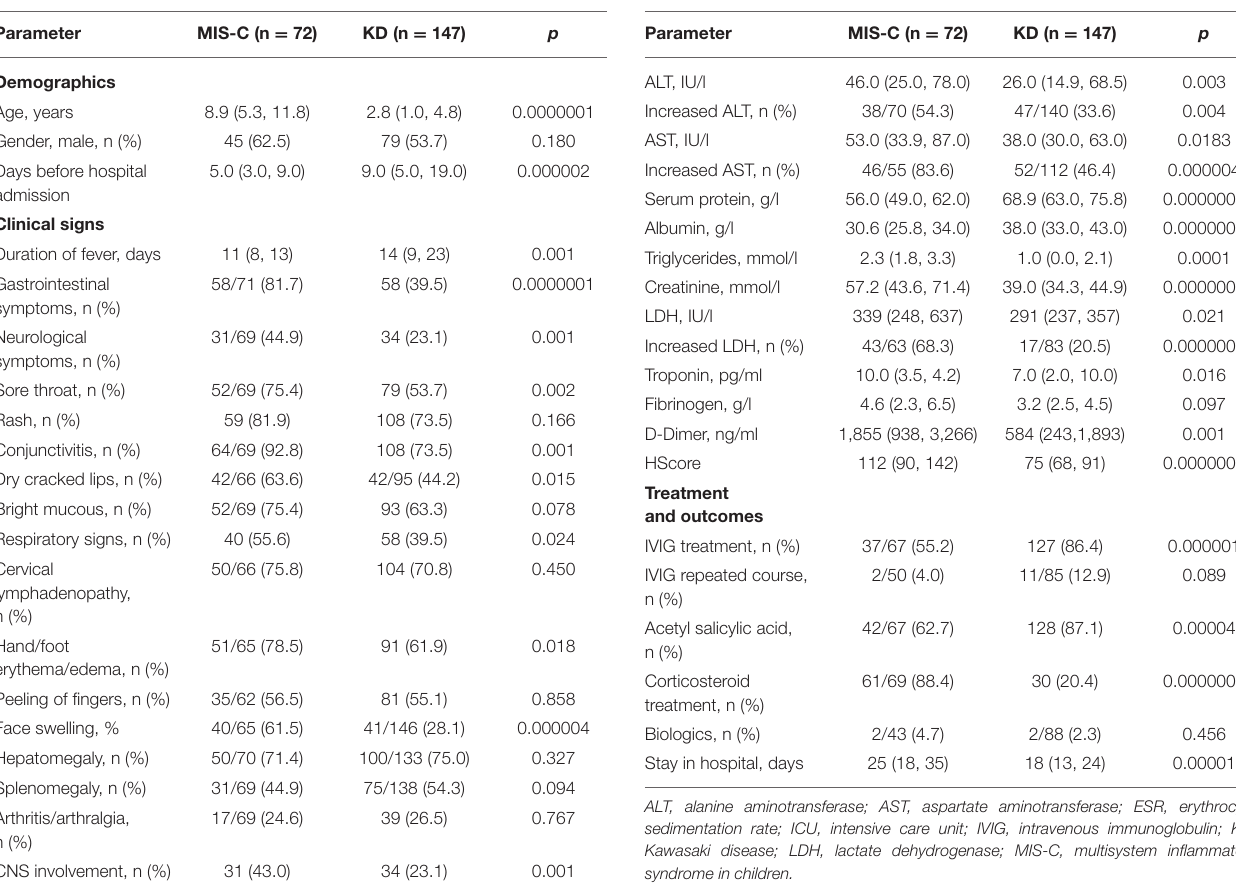
TABLE 1 | Comparison of clinical and laboratory data between MIS-C and